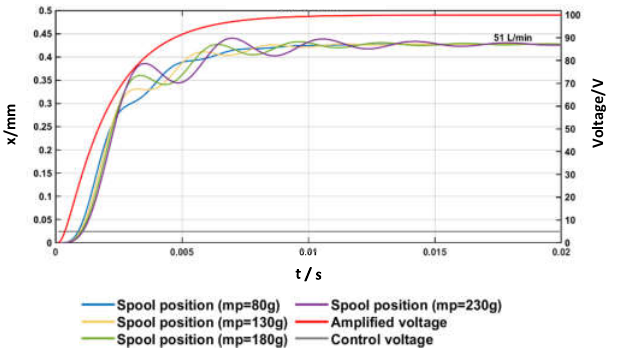
Figure 9. Open-loop step tests simulated for different values of m p ( p p − p T = 70 bar, C p = 90 Ns/m; ω n , a = 1400